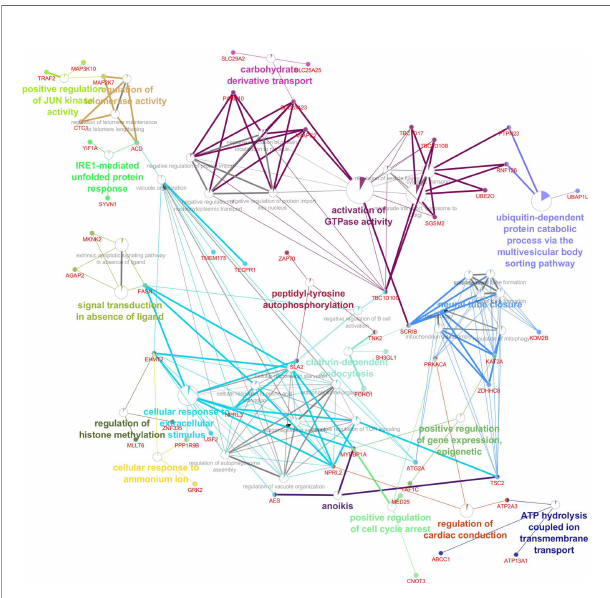
FIGURE 7 | The Gene, Gene Ontology and pathway, related modules involved in the disease severity of